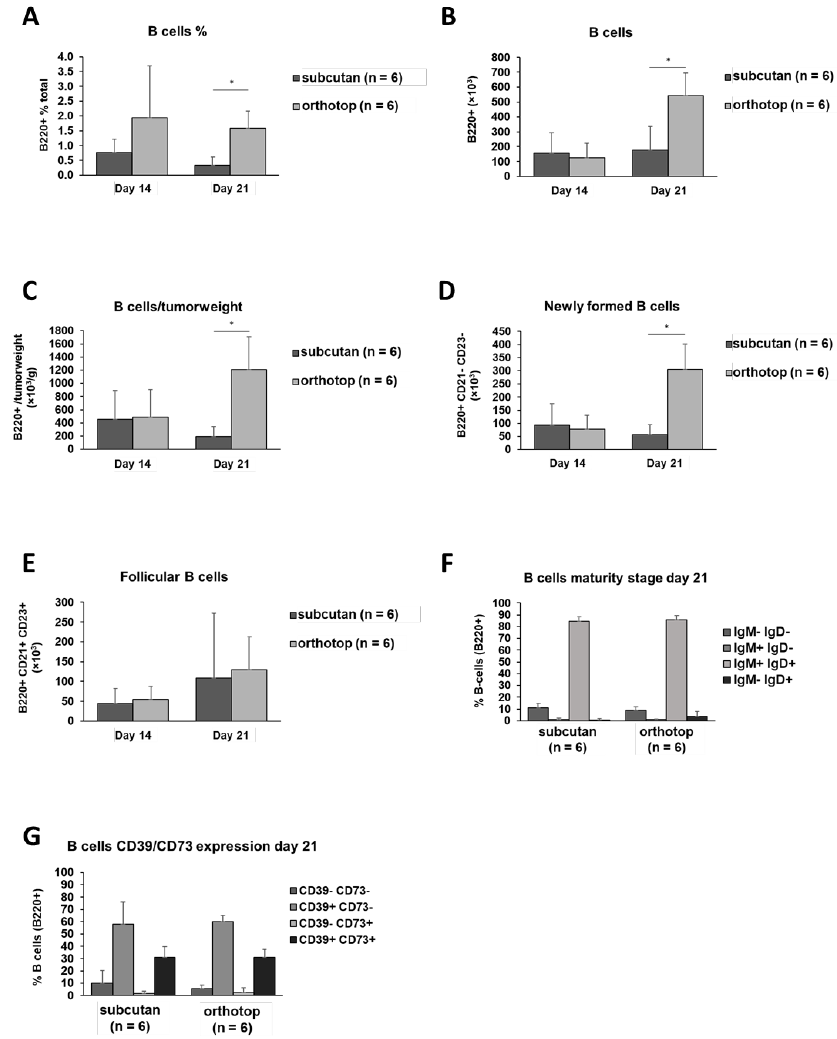
Figure 3. B cell populations in the tumor of orthotopic and subcutaneous HNSCC-bearing mice. ( A – C ) Tumors were har- vested 14 days and 21 days after tumor induction, and TIL were isolated. TIL were analyzed by flow cytometry for B220 + B cell frequency. For further characterization, B cells were divided into newly formed B cells ( D ) and follicular B cells ( E ). Furthermore, the B cell population was characterized by their expression of IgM and IgD ( F ) as well as CD39 and CD73 ( G ). On day 14 and day 21, the test group size for the subcutaneous group was n = 6, and for orthotopic group n = 6. p -values < 0.05 were considered to be significant with (*). Data shown here are listed in Table